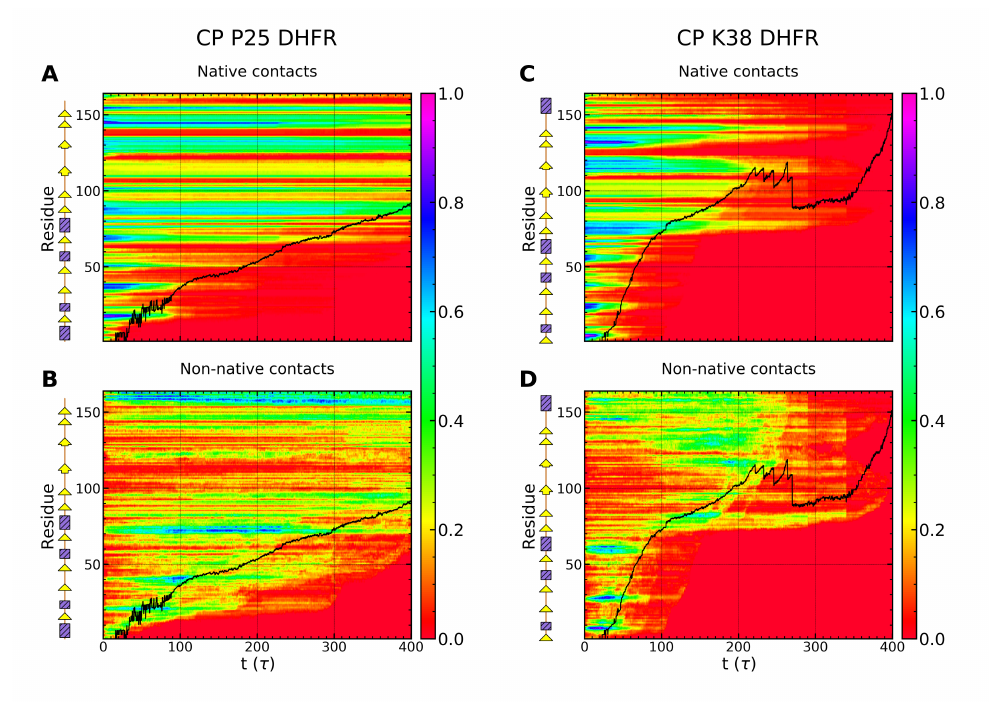
Figure 9. Direction-dependent time evolution of native and non-native content of circular permutant variants P25 and K38 of DHFR. ( A – D ) The time-dependent fraction of native Q N and non-native f NN contacts formed by secondary structural elements of wild-type DHFR during translocation in the N-C direction in the ( A , B ) high- and ( C , D ) low-energy barrier pathway. The time-dependent average translocation line (black) is also